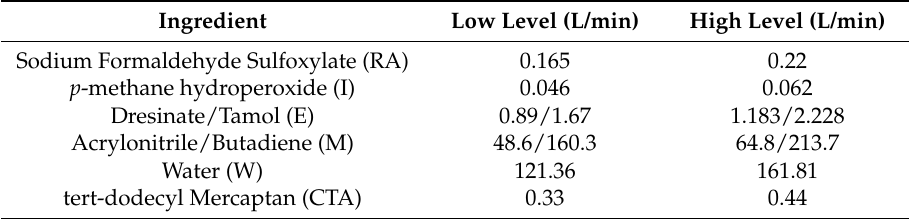
Table 1. Recipe ingredients to the first reactor in the reactor train and their levels. Ingredient Low Level (L/min) High Level